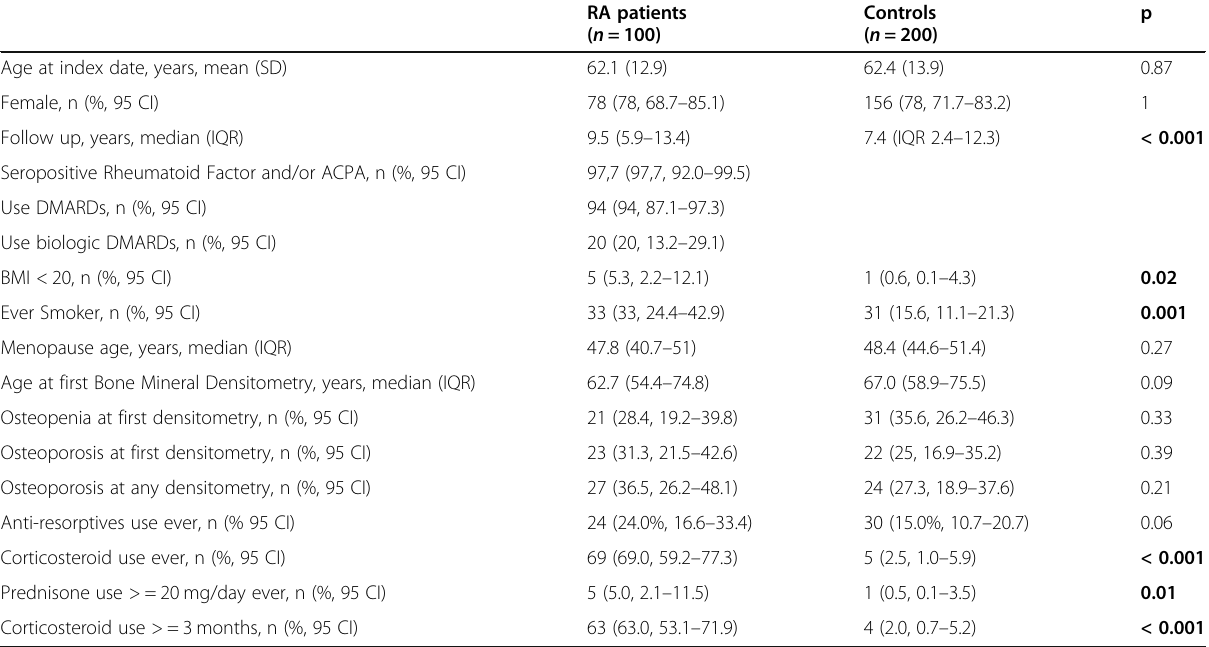
Table 1 Patient characteristics